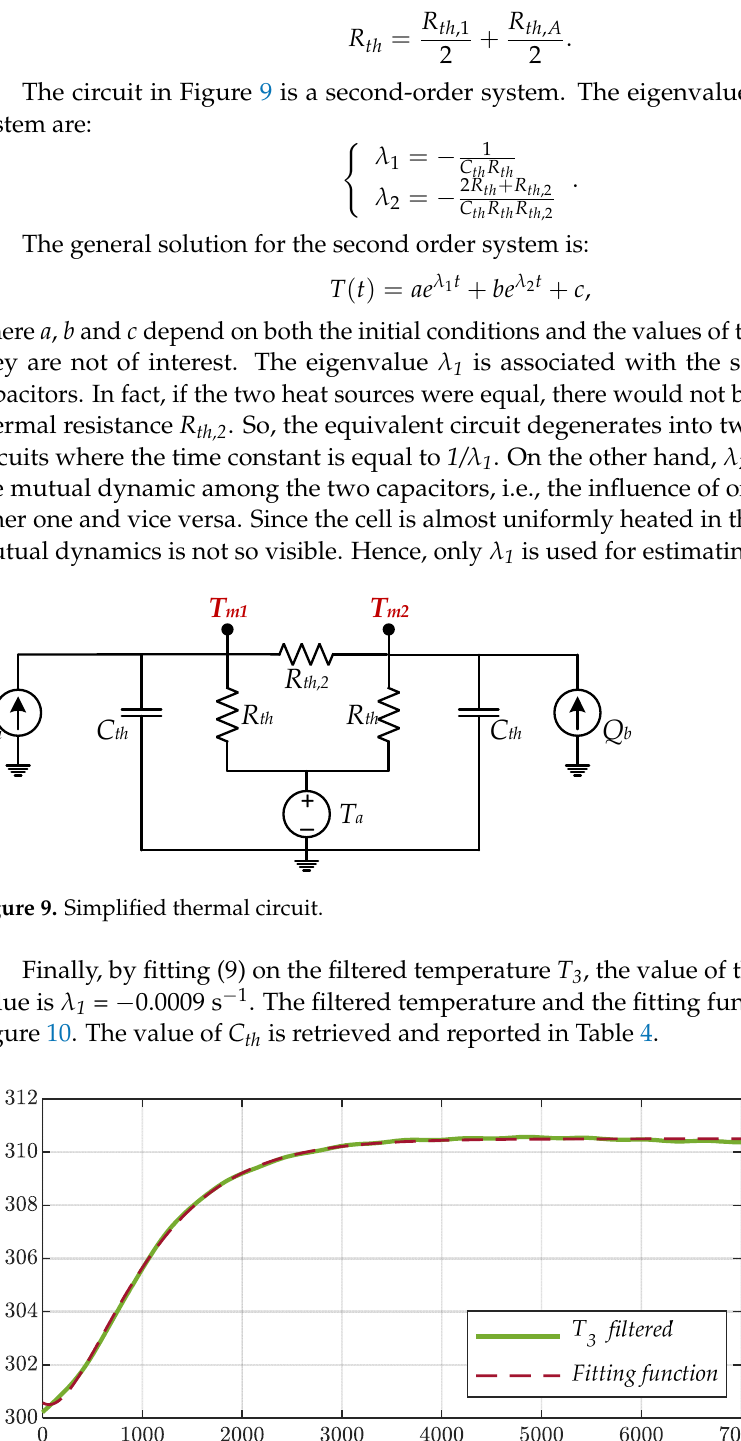
Figure 9. Simplified thermal circuit.